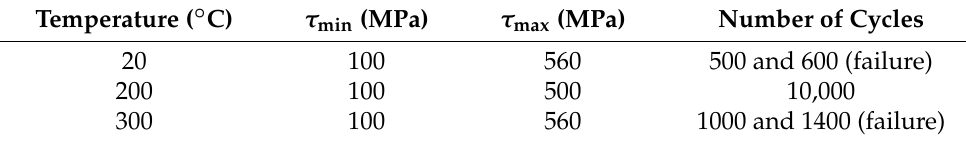
Table 6. Cyclic tests